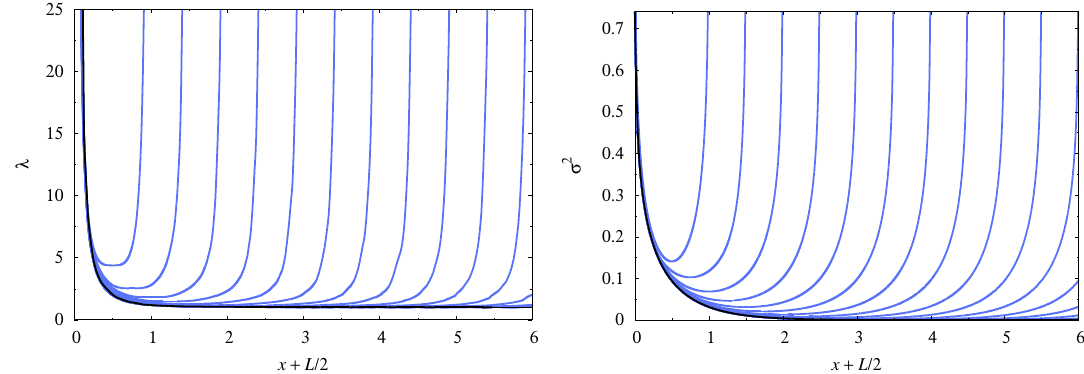
Figure 3 . The function (cid:21) ( x ) (left) and (cid:27) 2 ( x ) (right) which are the solutions of the gap equation, (cid:0) (cid:3) eq. (2.6) in the interval (cid:0) L ; 0 for various values of L ranging L = 1 (cid:24) 12. (cid:3) = 1 in this (cid:12)gure. 2 is quite reasonable ( L (cid:3) = 4 (cid:29) 1). The e(cid:11)ect of the boundaries is seen to propagate only for (cid:1) x (cid:24) 1 = (cid:3) from the latter: the system e(cid:11)ectively reduces to the standard 2D CP N (cid:0) 1 model in an in(cid:12)nite spacetime, as one moves away from the boundaries by (cid:24) 1 = (cid:3) or more, as expected on general